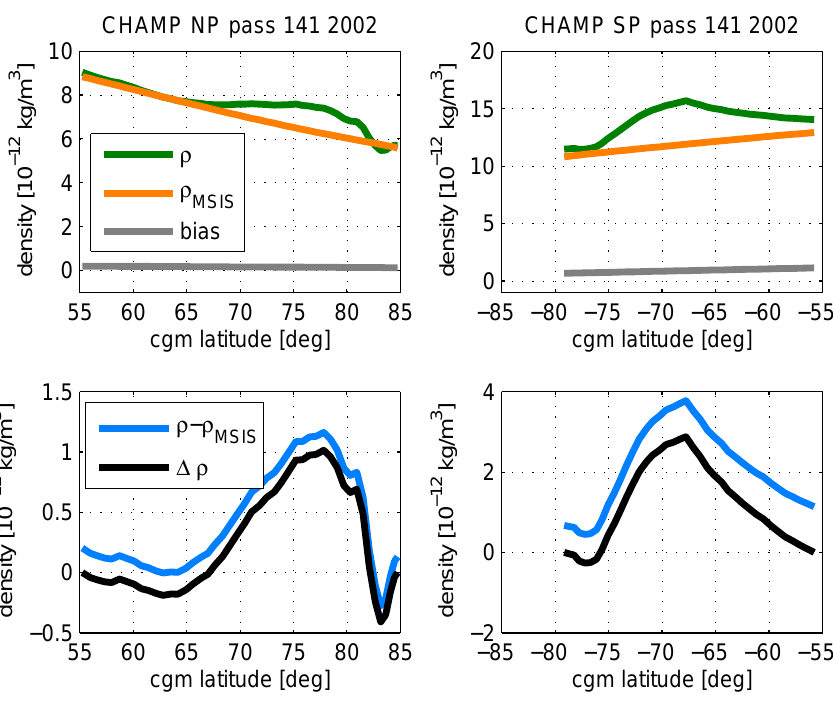
Fig. 1. Schematic overview of the anomaly identification procedure for the example of the overpass 141/2002 (10 January 2002). The left panels refer to the Northern Hemisphere and the right panels to the southern hemispheric part of the pass. The upper panels display the density from CHAMP data (green), the corresponding model density from NRLMSISE-00 (orange), and the linear bias function (grey). In the lower panels, the blue line indicates the difference between CHAMP-measured and NRLMSISE-00 density. The black line denotes the final density anomaly, 1ρ , which is used in this